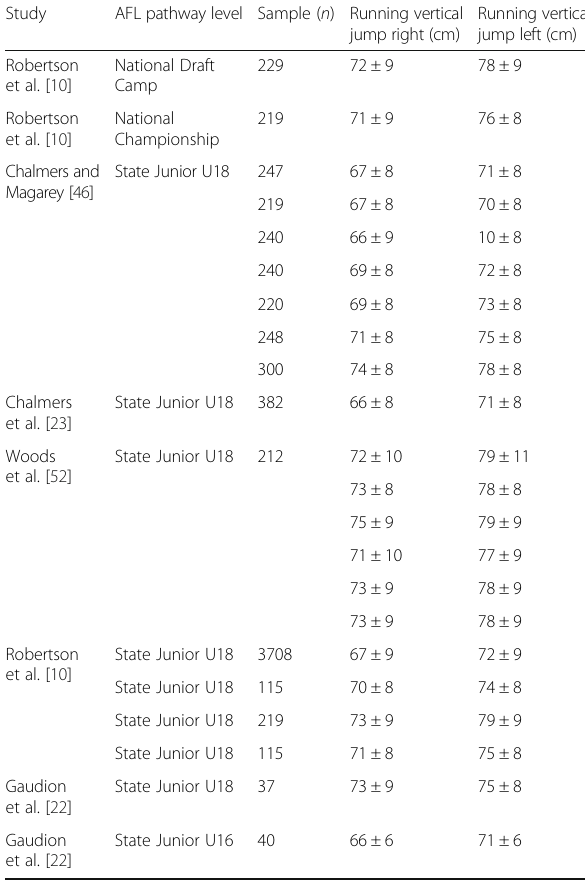
Table 1 Jump performance measures reported for level of AFL participation pathway. Measures represented as mean ± standard